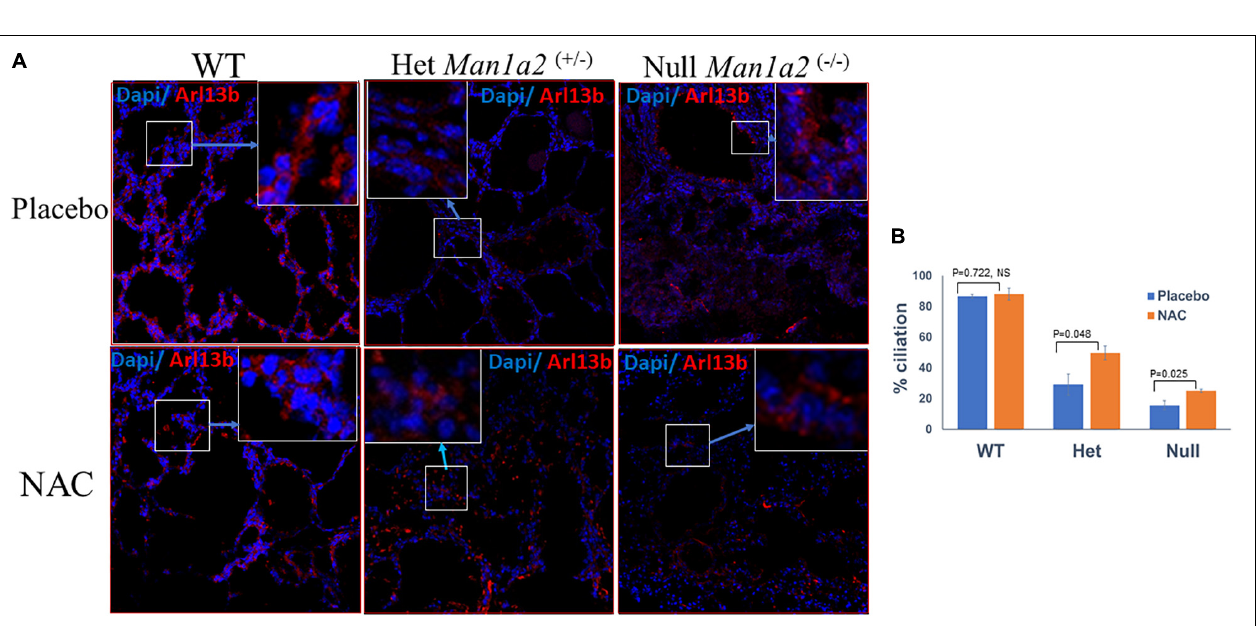
FIGURE 2 | (A) Confocal microscopy show Arl13b + cells and nuclei (blue, Dapi) in the lung sections of placebo (tow row) and N-Acetyl-cysteine-treated Man1a2 WT and heterozygous ( Man1a2 + / − ) newborn pups, and null ( Man1a2 − / − ) dead pups. Scale bars: 50 µ m. (B) Mean ± SEM frequencies of Arl13b + cells in lungs from the three groups of pups. The percent ciliation was expressed as percentage of Arl13b + cells quantified using ImageJ software. WT, Wild type; Het, Heterozygous Man1a2 ( + / − ) ; Null, Man1a2 ( − / − ) . The inset shows a high-magnification image of the Arl13b + cells area represented by the white rectangle. Four replicates were performed for all experiments. Error bars: